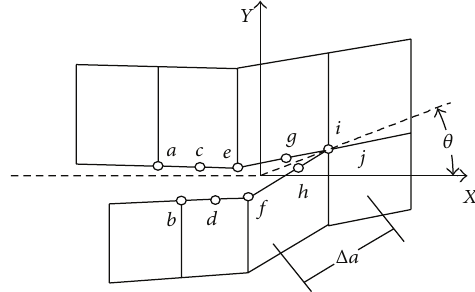
Figure 12: The finite element mesh configuration at the tip of crack with an angle against horizontal axis extended by the length of Δ𝑎 .